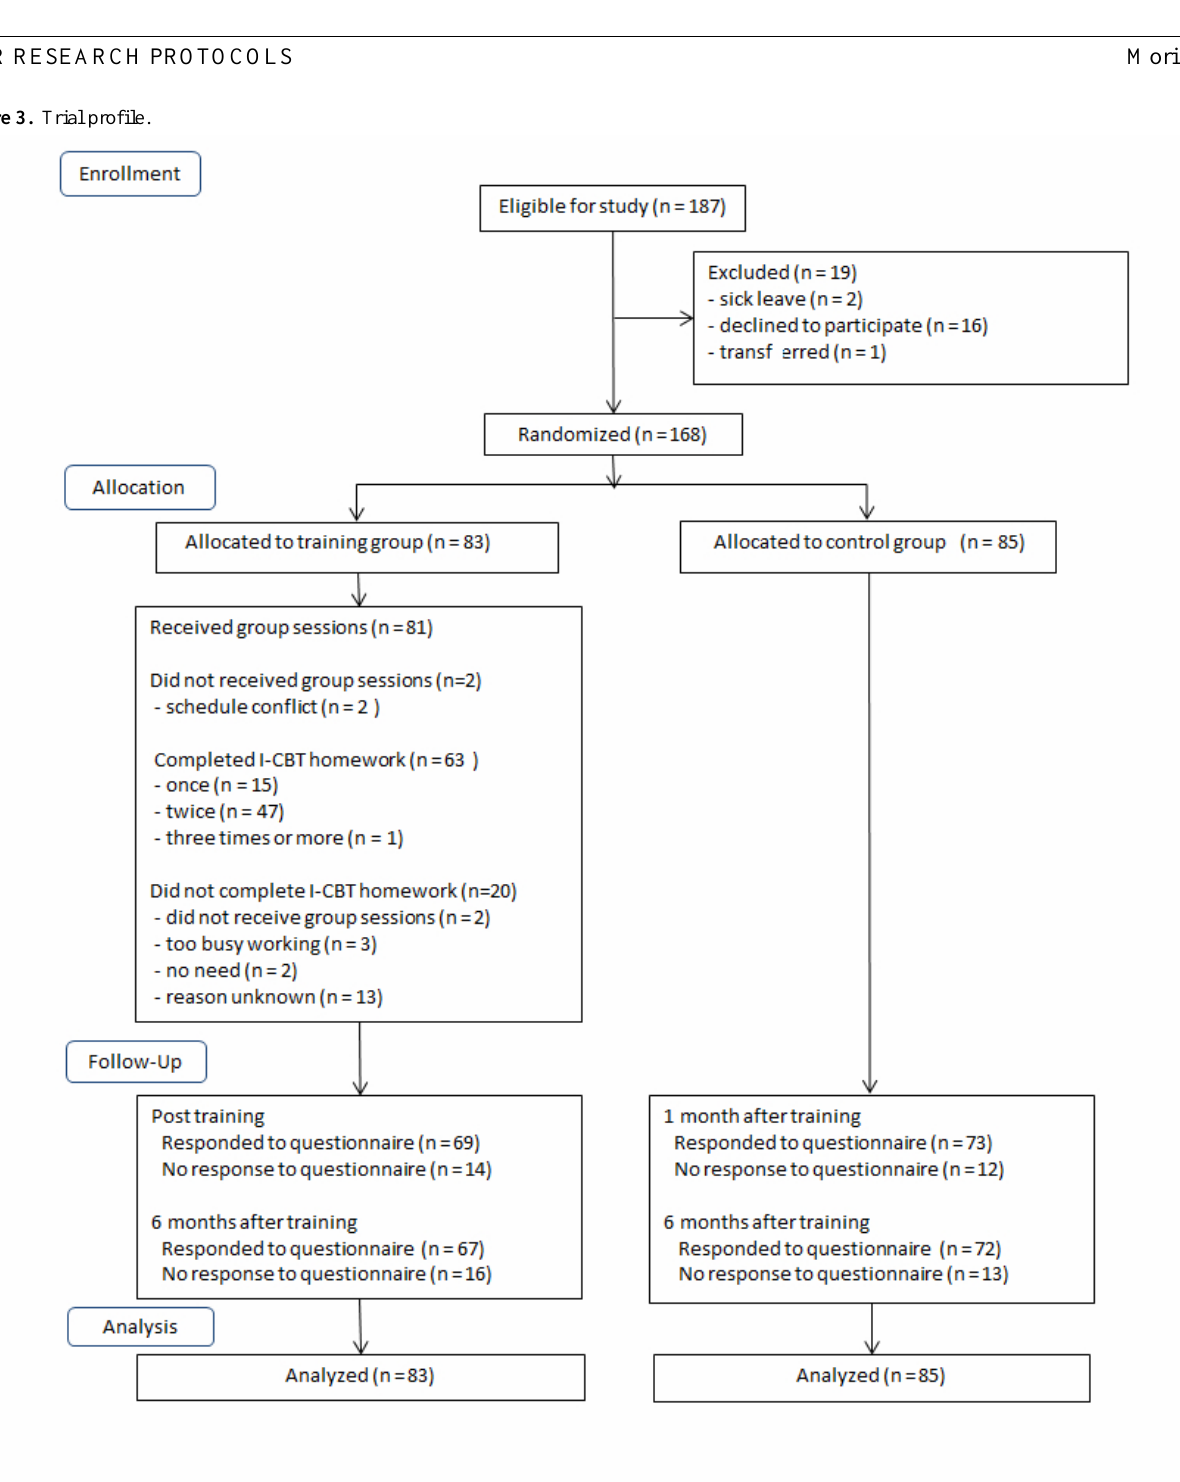
Baseline characteristics of the 168 participants are shown in Table 1. No missing data were observed. Of the 168 participants, 22% (n=37) were women (19%, 16/83 of training group and 25%, 21/85 of control group), 78% (n=131) were men